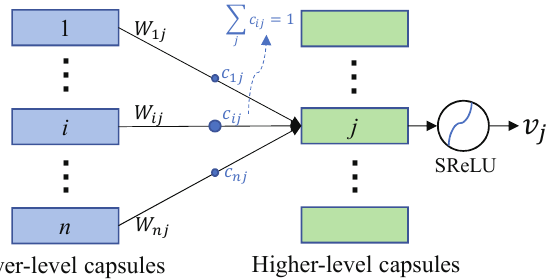
Figure 4. Connections between the lower-level capsules and higher-level